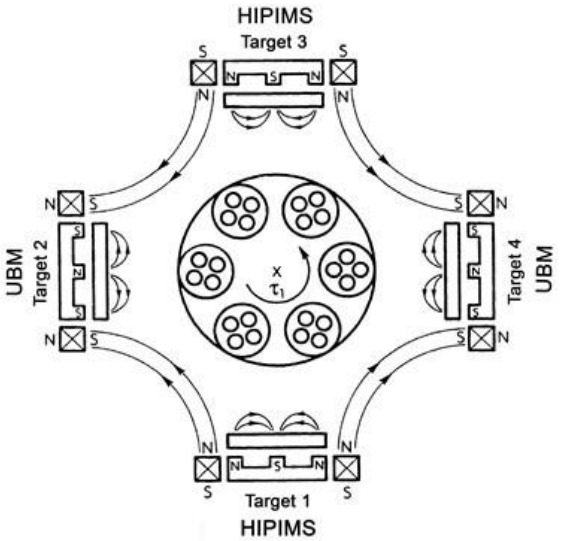
Figure 1. Schematic cross section of the deposition chamber- HTC 1000-4 PVD coater. Single-layer AlTiN coatings were deposited by random-arc reactive evaporation from alloy targets in an eight-evaporator Multi-Arc coating system at Ionbond, Ionbond UK Ltd, Consett, UK using commercially established and widely proven coating deposi- tion conditions.